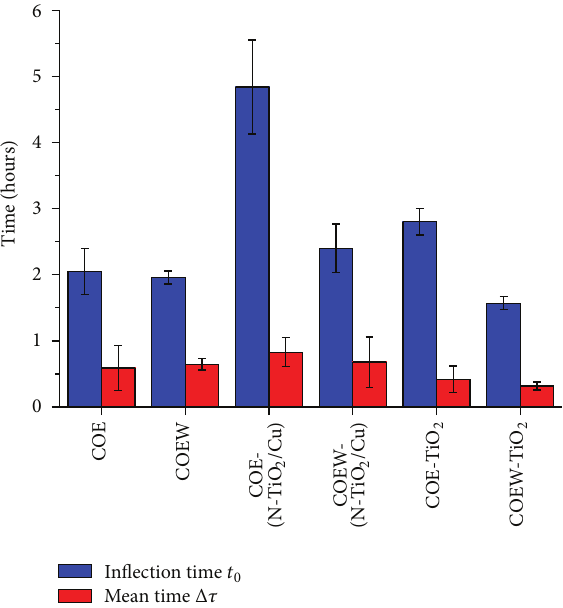
Figure 9: The time parameters of the logistic curve establishing the differences induced in the crude oil extracts by UV-Vis